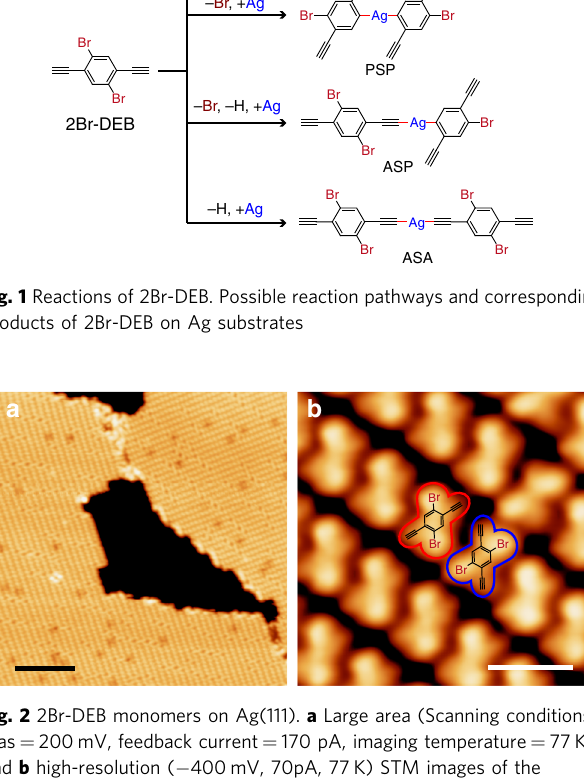
Fig. 2 2Br-DEB monomers on Ag(111). a Large area (Scanning conditions: Bias = 200 mV, feedback current = 170 pA, imaging temperature = 77 K) and b high-resolution ( − 400 mV, 70pA, 77 K) STM images of the molecular assembly formed by 2Br-DEB monomers on Ag(111). Molecules of opposite adsorption chirality are marked in red and blue in b , respectively. Scale bars: a 10 nm, b 1